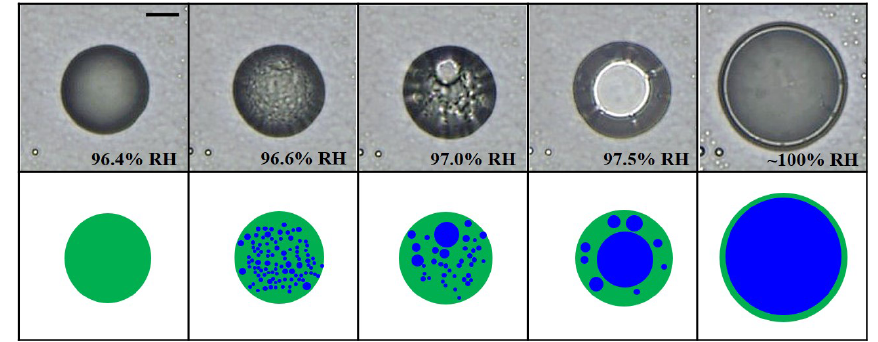
Figure 1. Optical images of a SOA particle produced from α -pinene ozonolysis ( α -pinene O 3 no. 1 in Table 1) with increasing RH. The purpose of the illustrations is to clarify the images. Green is the SOA-rich phase, and blue is the water-rich phase. The scale bar is 20µm.